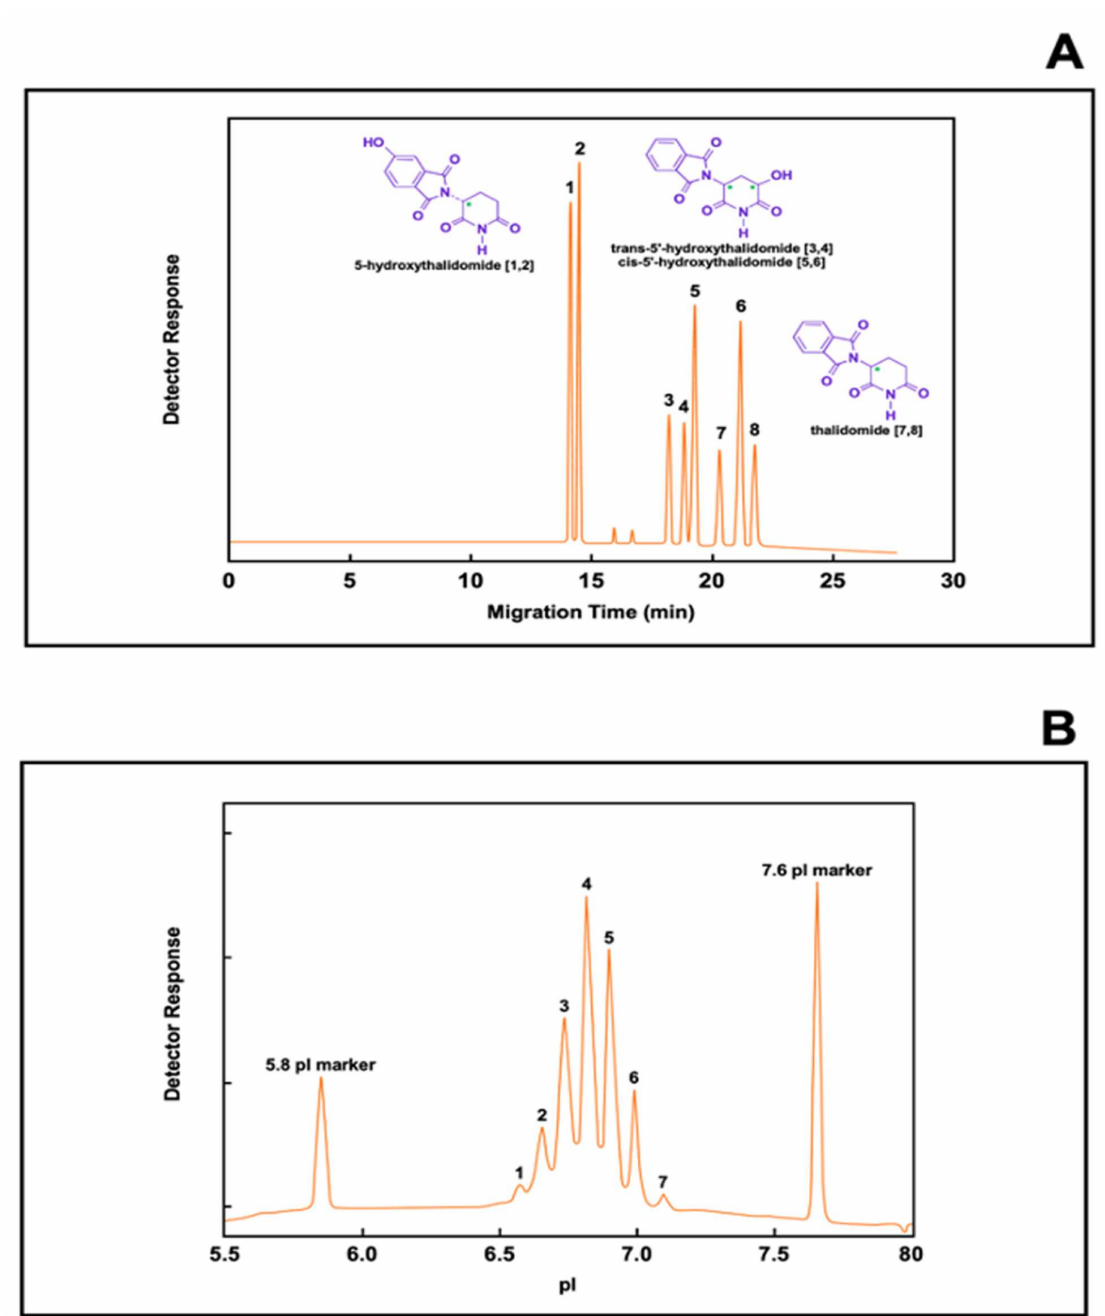
Figure 4. Depicts the power of resolution of capillary electrophoresis. ( A ) depicts an electropherogram showing the simultaneous separation of thalidomide and its hydroxylated metabolites. In this case, the separation of thalidomide and its metabolites was performed by chiral capillary chromatography (CCC) using a single point detection at the outlet end of the capillary. ( B ) depicts an electropherogram showing the various charged isoforms of a recombinant monoclonal antibody. In this case, the separation of the antibody isoforms was performed by capillary isoelectric focusing using a detection system that covers the entire capillary, known as imaged capillary isoelectric focusing (iCIEF) containing the pI markers 5.8 and 7.6. Figures modified from